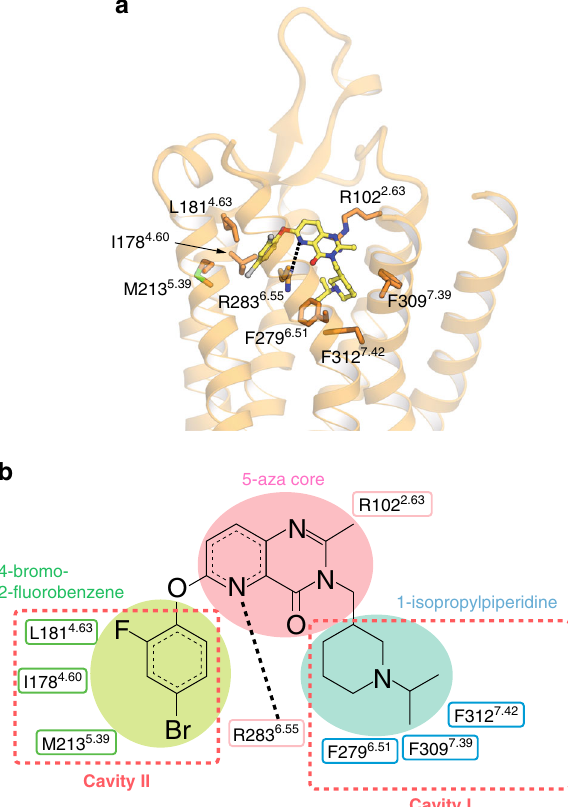
Fig. 3 Binding mode of Compound 21. a Side chain interactions within 4.0 Å residues are shown in stick representation. Hydrogen bonds are shown as black dashed lines. b Schematic representation of the interactions between the ghrelin receptor and Compound 21, analyzed using the Discovery Studio 2016. The black dot line indicates a hydrogen